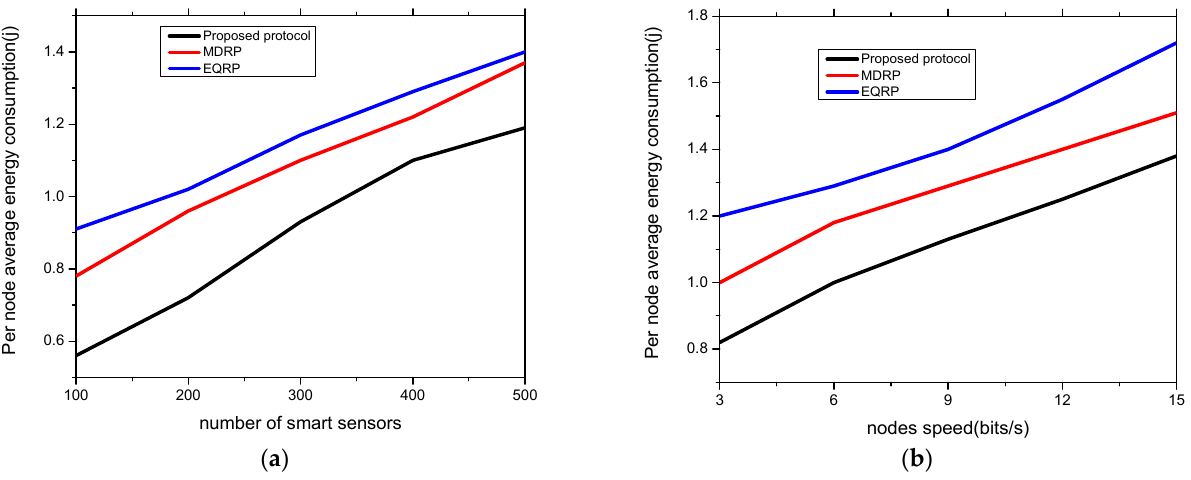
Figure 7. Varying smart sensors and nodes speed in terms of energy consumption. ( a ) Energy consumption and varying sensors; ( b ) energy consumption and varying node speed.